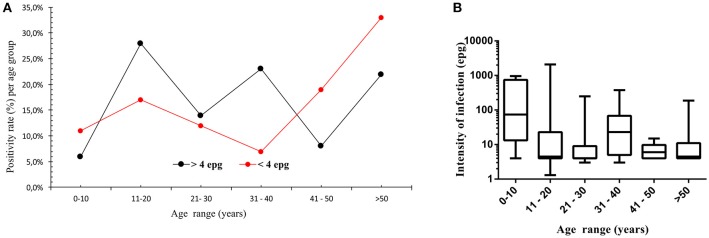
Positivity rate for S. mansoni infection per age group (A), indicated for individuals detected by quantitative Kato-Katz method (black squares, >4 epg, n = 71) and for individuals detected by other qualitative parasitological methods, such as Helmintex® and saline gradient (red squares, <4 epg, n = 42). In (B), median intensity of infection and interquartile ranges per age group, indicated as eggs per gram of feces and determined by the Kato-Katz method for the different age groups (n = 71).